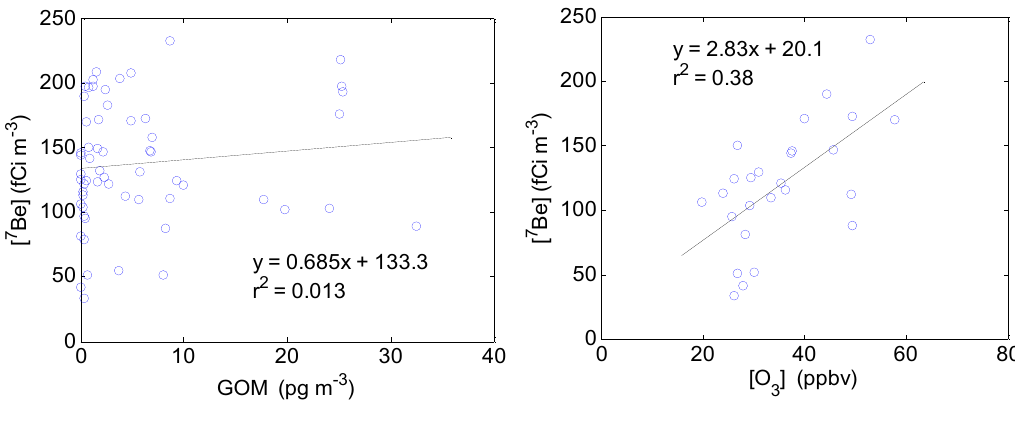
Figure 10. Correlation between 7 Be and GOM for the entire study ( Left ) and between 7 Be and ozone for nighttime periods when the solar radiation was less than 200 W·m − 2 ( Right ) during the spring 2011 intensive. Hourly GOM and ozone measurements were averaged based on the time periods when 7 Be samples were